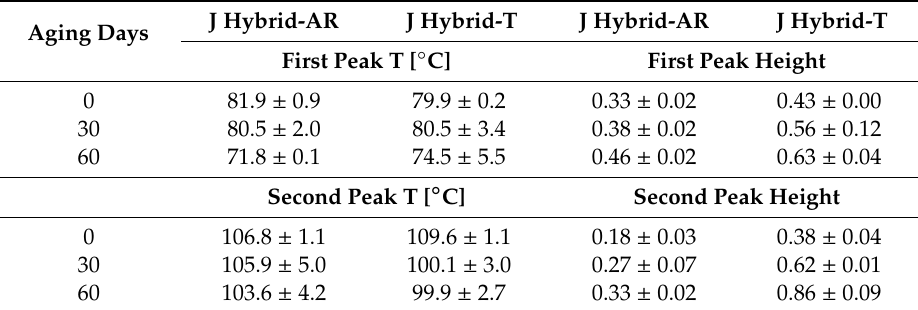
Table 5. Damping properties of J Hybrid composites for each aging condition.